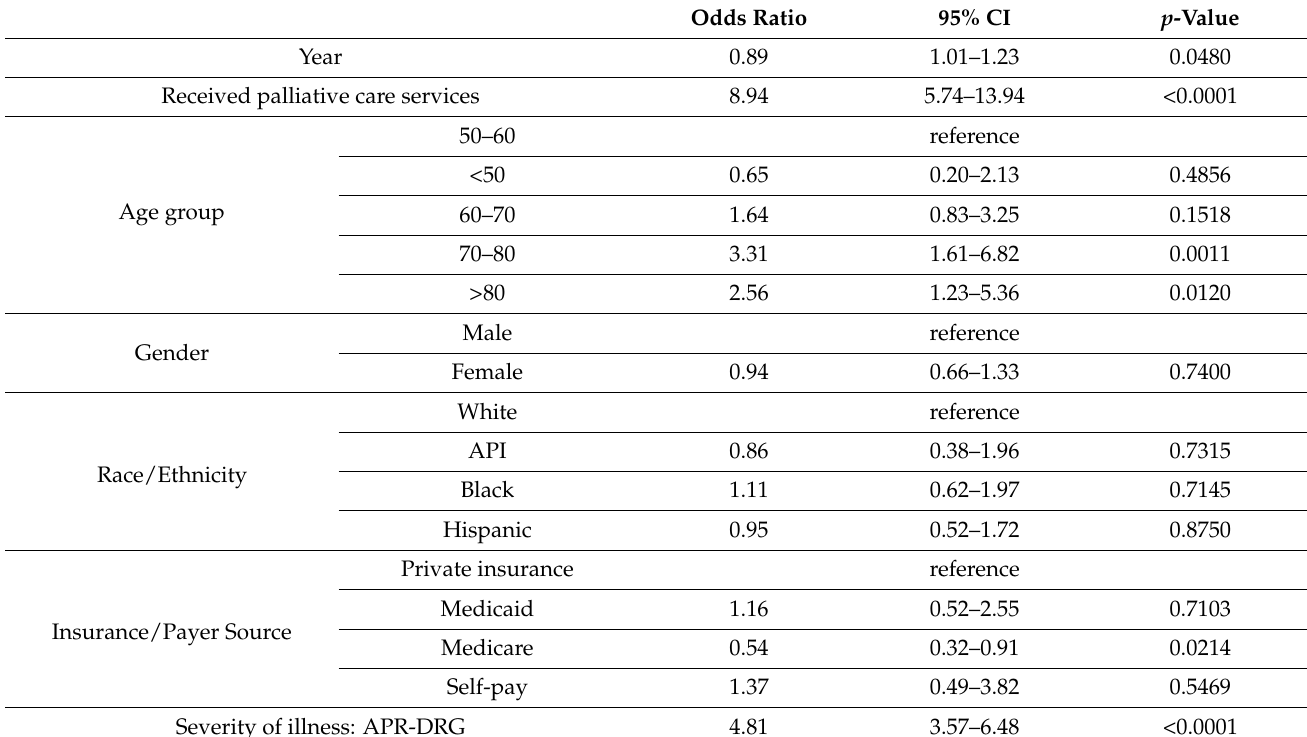
Table 5. Factors associated with in-hospital death in ECC in US hospitals from 2007 to 2016. NIS Data. Odds